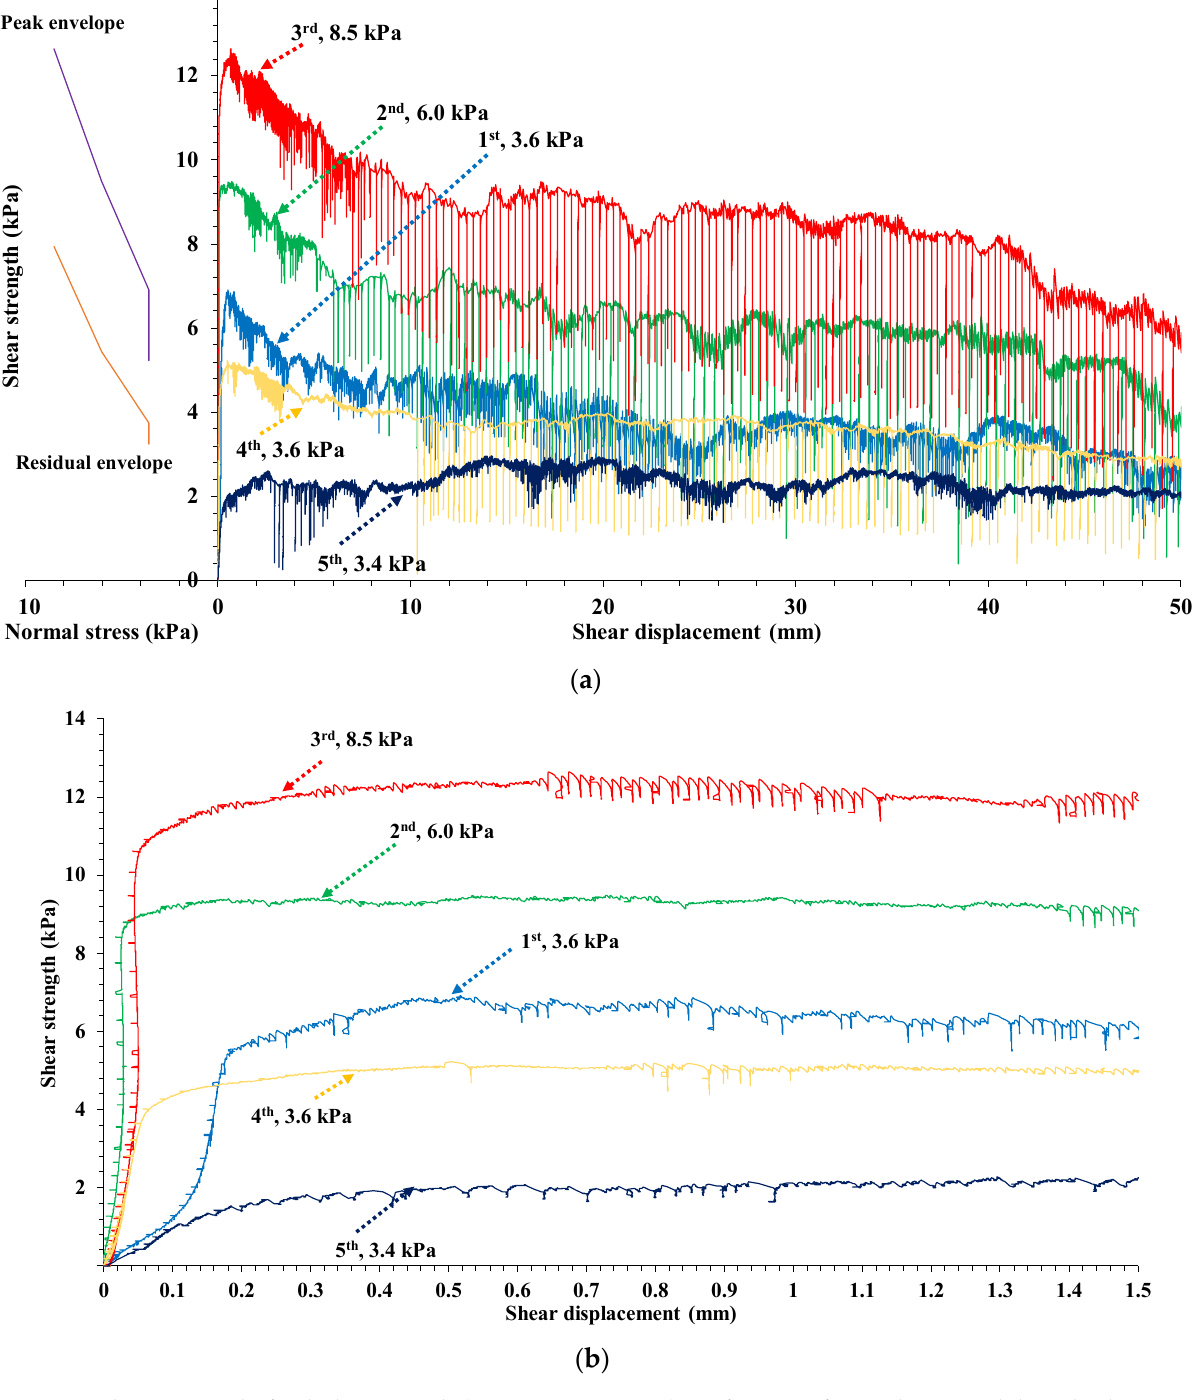
Figure 11. The photogrammetry method and Z ′ 2 to define the JRC roughness of the slabs ( a ) pre- shearing of the large sample (2000 mm × 1000 mm), ( b ) pre-shearing of the medium sample (500 mm × 250 mm).